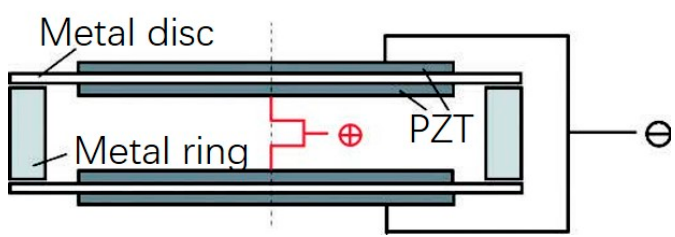
Figure 14. Structural diagram of the double-sided triad-curved hydrophone.